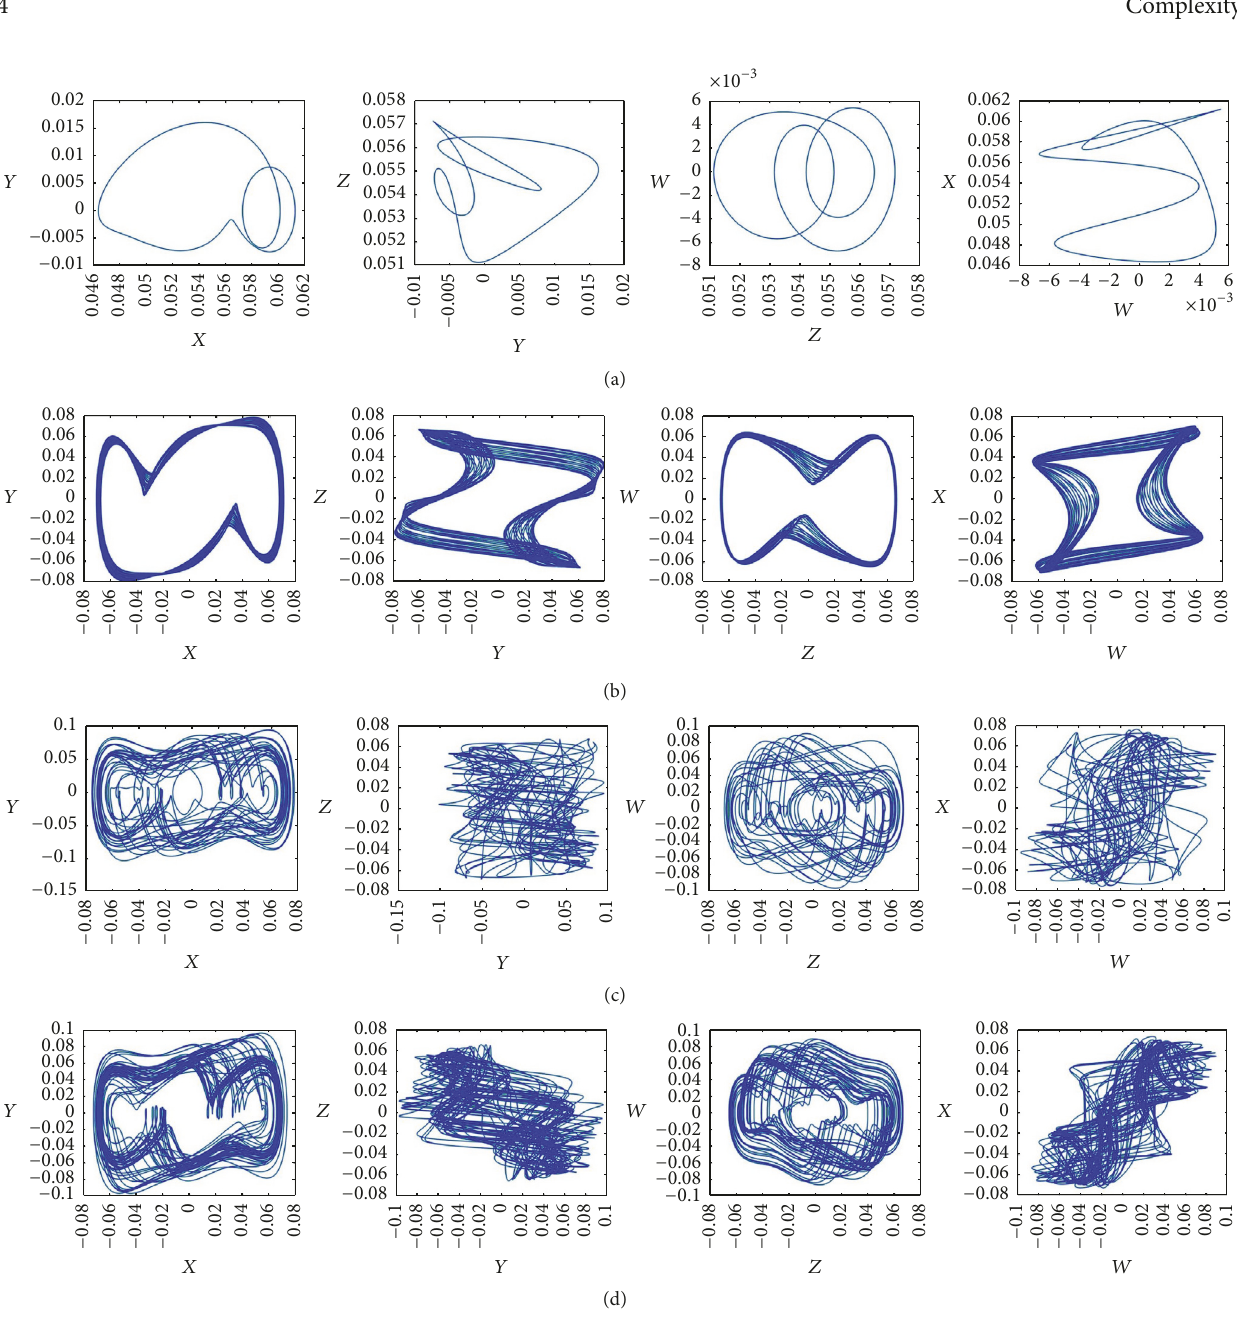
mathematical equations, approximation through a rational system in discrete time, and approximation of the fractional system using rational function in continuous time. Most in discrete time in which the fractional order system is replaced by its discrete equivalent and approximated again by truncating the polynomial series, which reduces the requirement of infinite